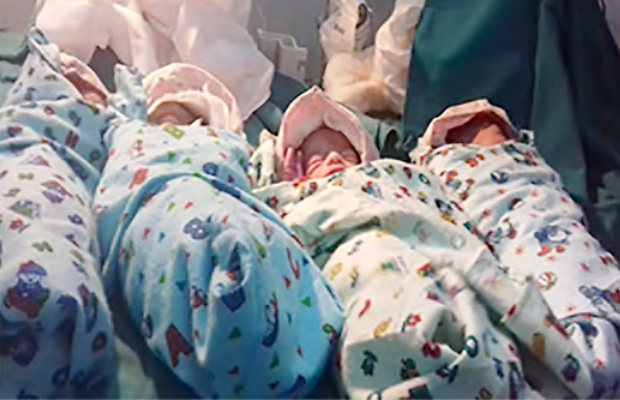
Fig 2 : All the four babies together in NICU. (color pic available online)